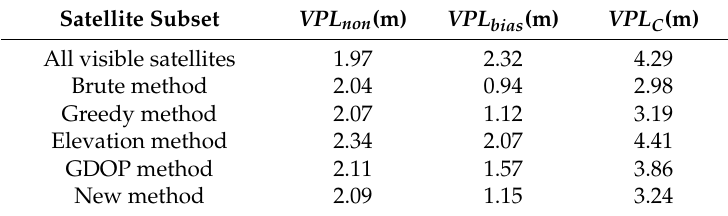
Table 9. Average for the optimal satellite subsets obtained by the new method.